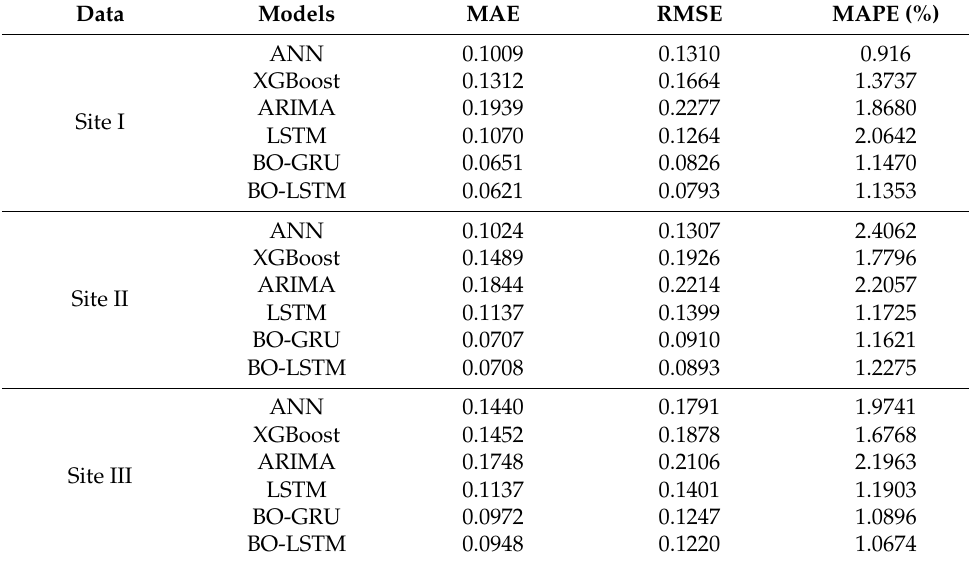
Table 3. Comparison of six forecasting models on three Sites